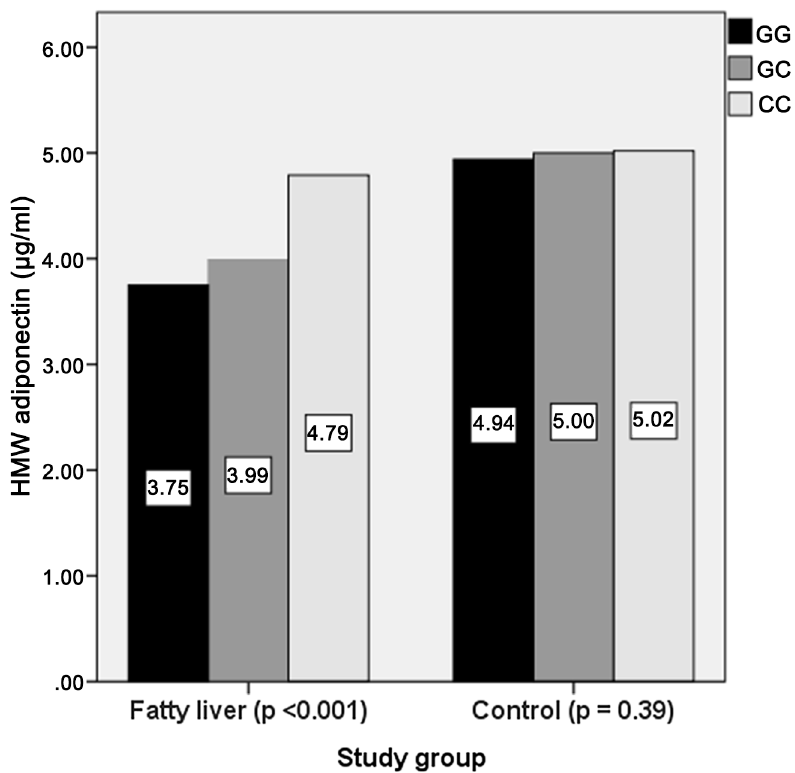
Fig 1. Plasma HMW adiponectin levels in the study groups. Median plasma HMW adiponectin levels were compared between GG, GC and CC genotypes of SNP rs266729 in patients with non-alcoholic fatty liver disease and